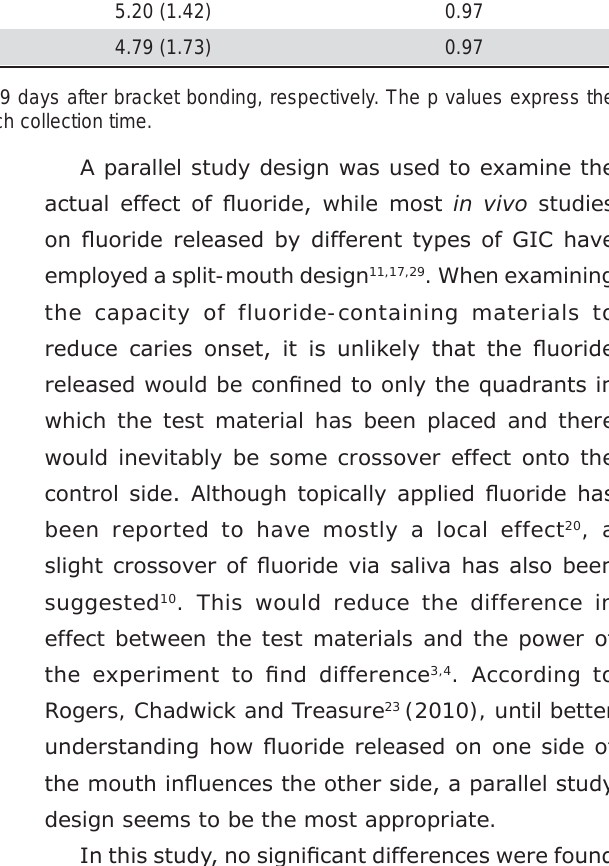
, T , T , T = 7, 21, 35, and 49 days after bracket bonding, respectively. The p values express the 7d 21d 35d 49d